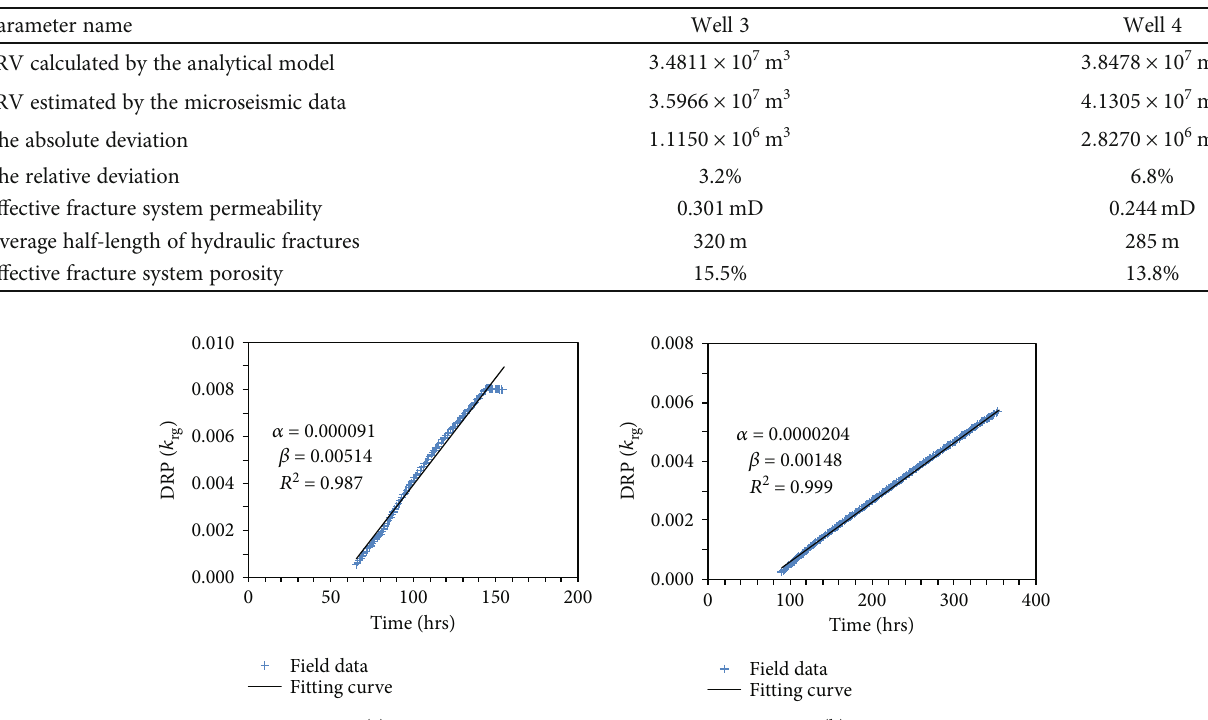
Table 1: Di ff erent results of the analytical model and microseismic data.